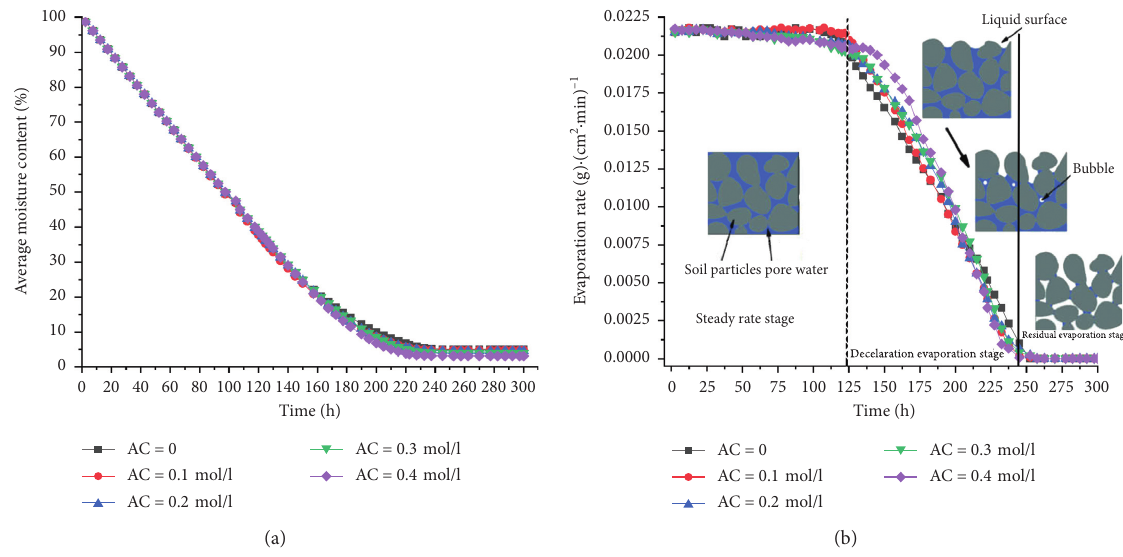
Figure 4: Drying time variations: (a) average moisture content of contaminated samples with different acid concentrations vs. time, (b) rate of evaporation of contaminated samples with different acid concentrations vs. time.